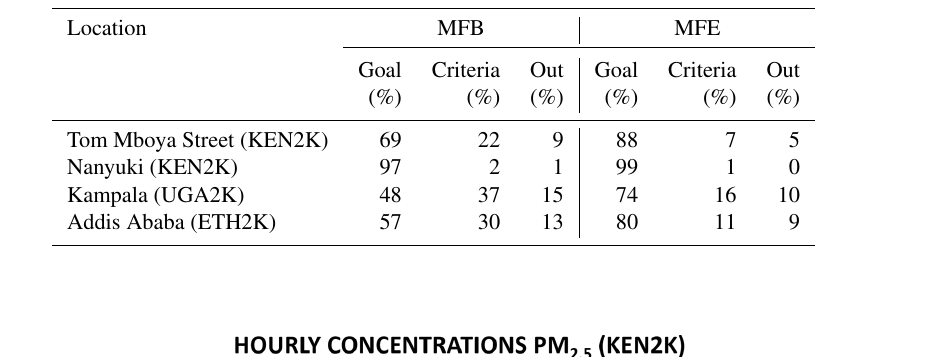
Table 5. The hourly mean fractional bias (MFB) and mean fractional error (MFE) percentage of points within the goal range (Goal), within the diagnostic range (Criteria), and outside of the reliability criteria range (Out) from model outputs extracted from the four analysed locations.